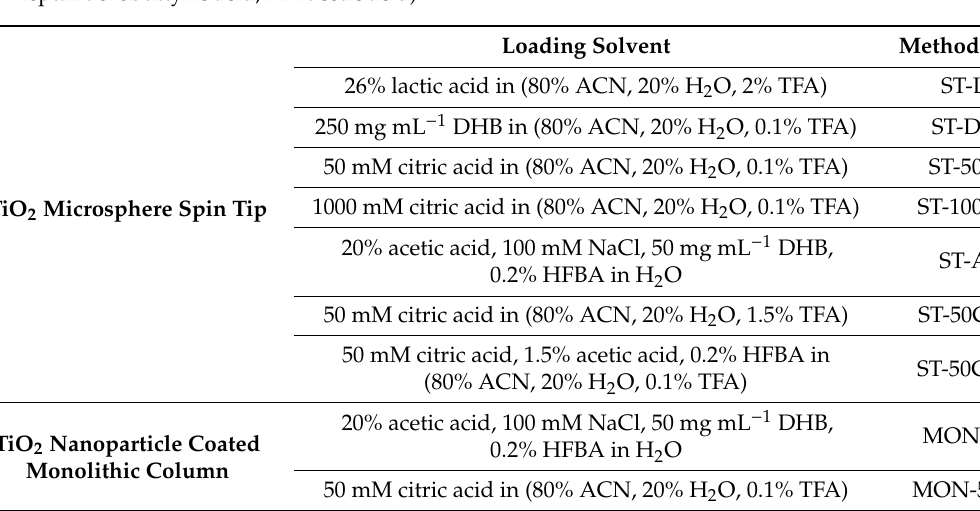
Table 1. Sample loading conditions and abbreviations of the tested methods. First, five di ff erent loading solvents with the spin tip and two with the monolithic column were investigated. Second, the ST-50CA method was modified to decrease the non-specific binding of non-phosphorylated peptides. (ACN: acetonitrile, TFA: trifluoroacetic acid, CA: citric acid, DHB: 2,5-Dihydroxybenzoic acid, HFBA: heptafluorobuttyric acid, AA:acetic